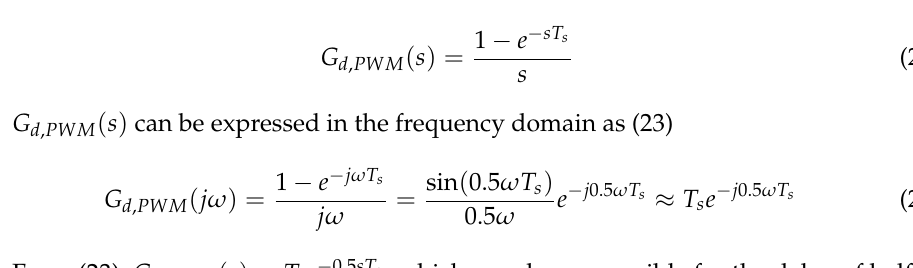
Figure 17. Using auxiliary circuit active damping